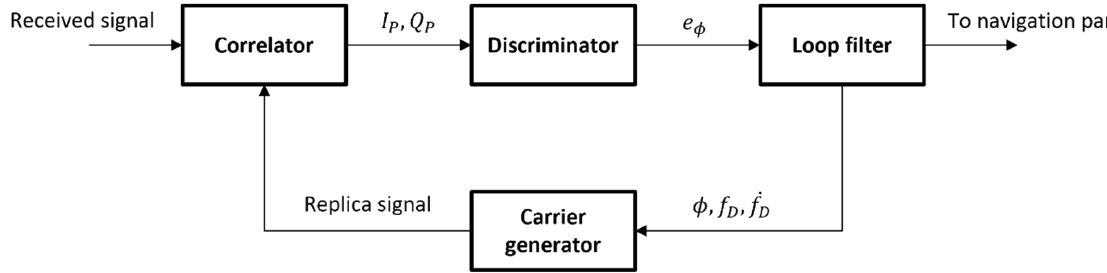
Figure 7. Simplified structure of conventional carrier tracking loop.